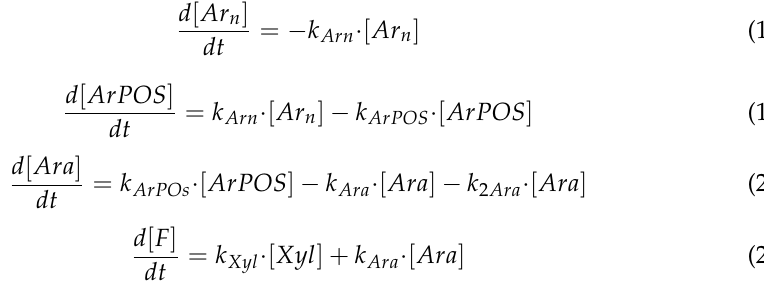
Figure 5. Experimental and calculated values determined for arabinosyl groups and the derived products. Table 6. Results calculated for the parameters governing the reactions of arabinosyl groups and the derived products.